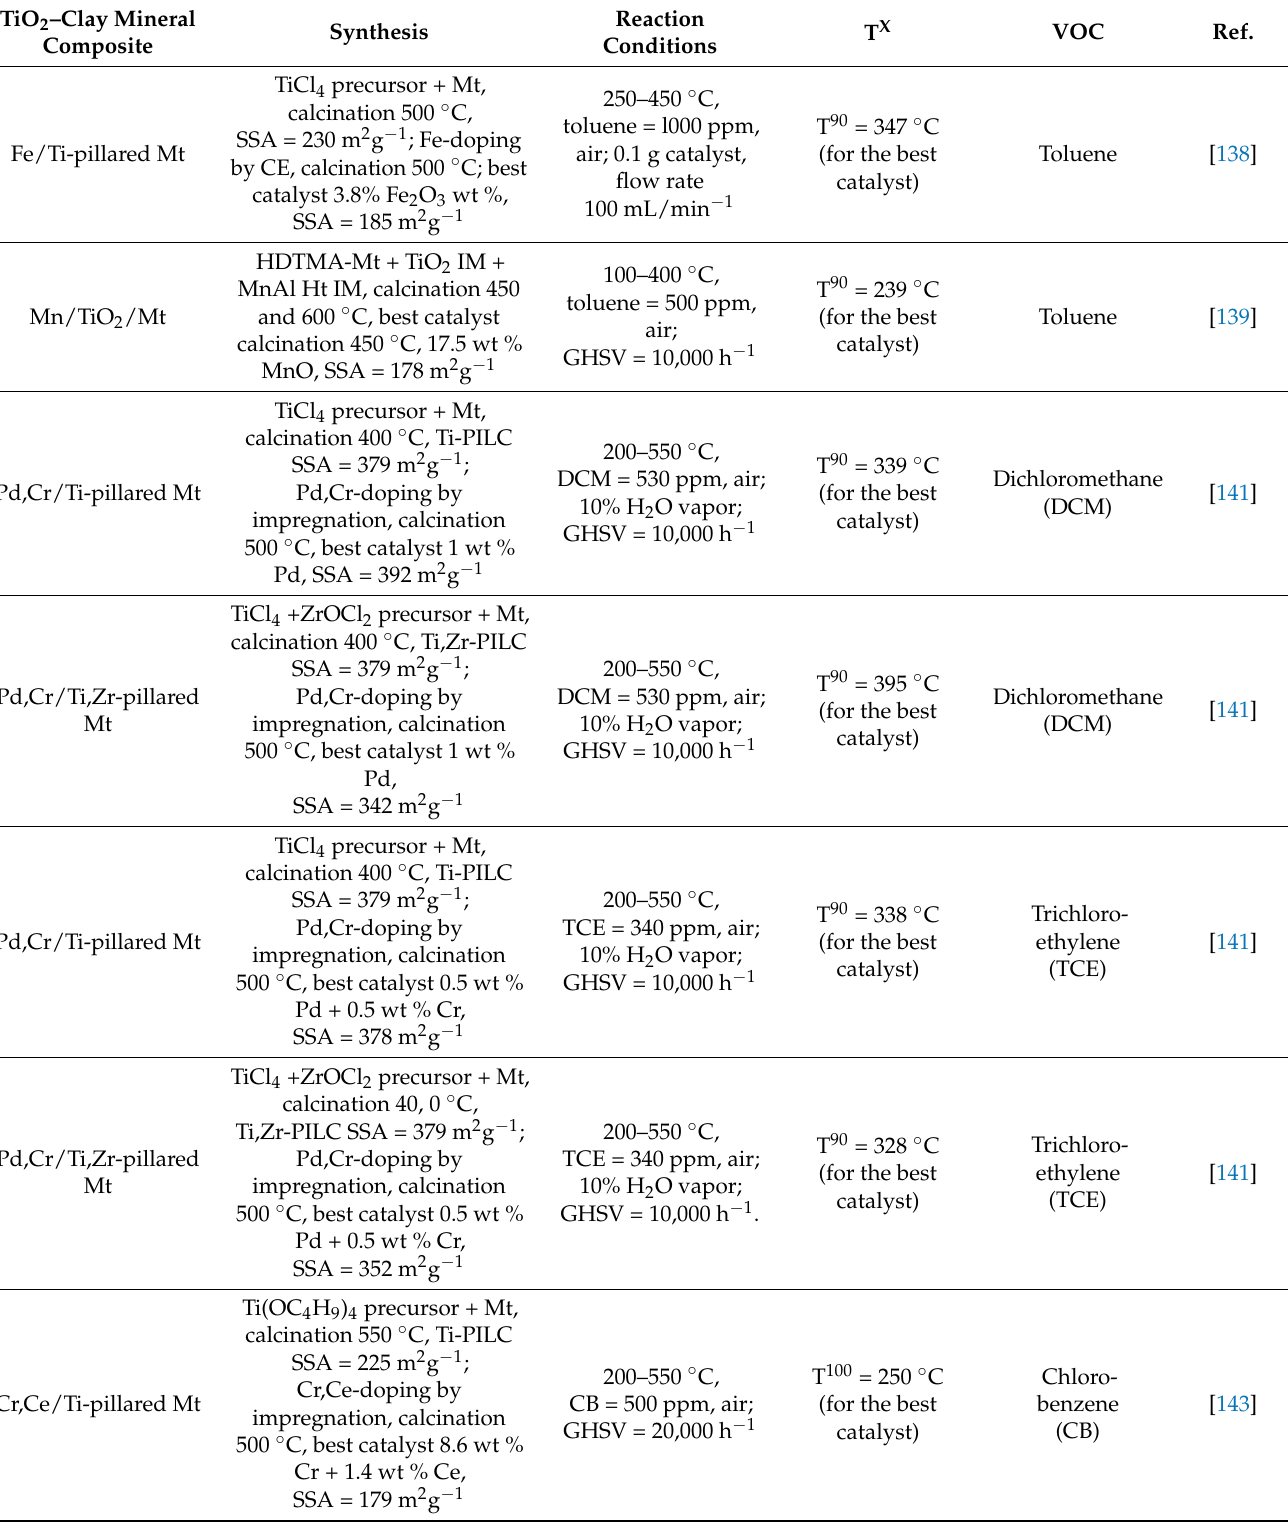
Table 3. Summary of main synthesis and catalysis data for the most relevant examples of TiO 2 –clay mineral composites used as catalysts for the combustion of VOCs (T X = temperature at X% conversion), Ht—hydrotalcite, Mt—montmorillonite, Pal—palygorskite, HDTMA—hexadecyltrimethylammonium cation, IM—inverse microemulsion, CE—cation exchange, GHSV—gas hourly space